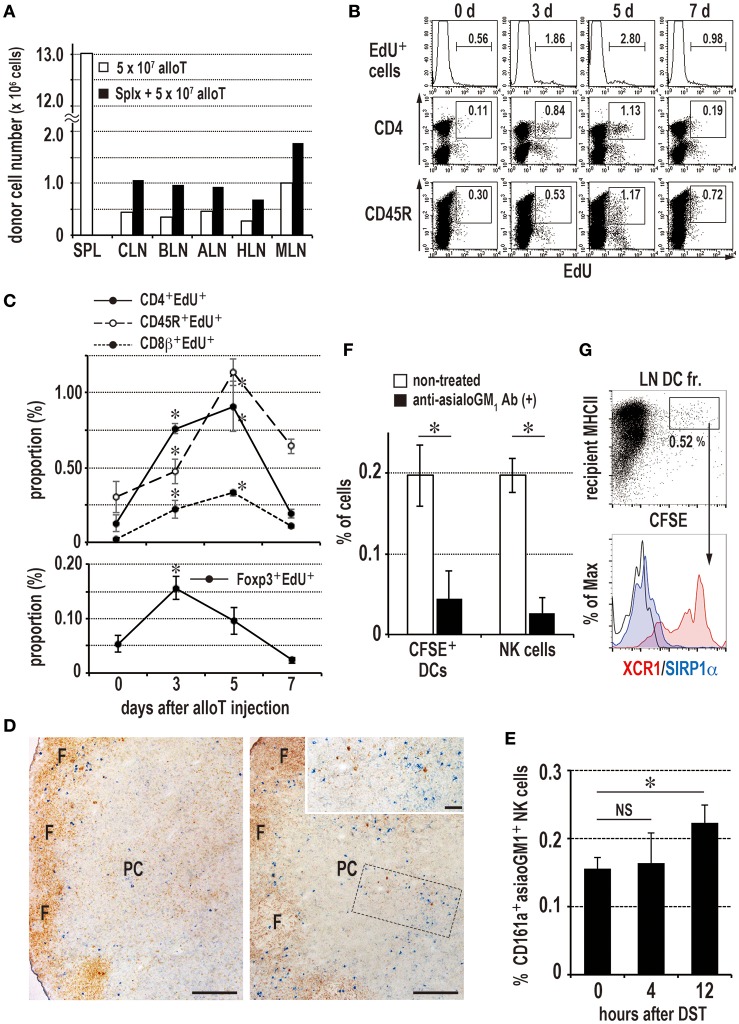
Induction of the donor-specific transfusion (DST) response in the LNs of splenectomized (A–C,F,G) or eusplenic (D,E) recipients. The recipient peripheral LNs were analyzed in the same manner as the spleen (Figure 1, 3, 4). (A) Two-color FCM analysis of the number of migrated donor T cells in recipient LNs 24 h after injection. Roughly twice as many donor T cells migrated to the LNs than in the eusplenic control. SPL, spleen; CLN, cervical LN; BLN, brachial LN; ALN, axillary LN; HLN, hepatic LN; MLN, mesenteric LN. (B,C) The time kinetic changes in each proliferating cell type/total LN cells by FCM analysis. The CD4+ T cells and regulatory T cells peaked at 3–5 days and 3 days, respectively, whereas CD45R+ B cells and CD8β+ T cells peaked at 5 days (mean ± SD, n = 3 rats each, *P < 0.05). (D,E) Kinetics of NK cells in the peripheral LNs after DST. (D) Double immunostaining of the LNs for asialo GM1 (blue) and rat IgM (brown) at 0 (left panel) and 12 h (right panel). Inset indicates increased asialo GM1+ NK cells (blue) in the paracortex (PC). Scale bar = 200 μm or 50 μm (inset). F, lymph follicle. (E) The proportion of NK cells significantly increased in the LNs at 12 h (mean ± SD, n = 3 rats each, *P < 0.05). (F) Kinetics of donor cell phagocytosis in the peripheral LNs after donor T cell injection. Phagocytosis of donor cell fragments by DCs was detected 36 h after transfer of 2 × 107 CFSE labeled T cells. With anti-asialo GM1 antibody (Ab) treatment, the numbers of recipient CFSE+ phagocytic DCs and NK cells were significantly reduced compared to non-treated control (mean ± SD, n = 3 rats each, *P < 0.05). (G) Phenotype of CFSE+ phagocytic DCs in the peripheral LNs. Note that they were XCR1+SIRP1α−, similar as those of spleen.